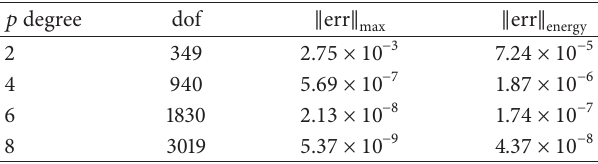
Table 1: Enriched meshfree method errors, measured in max and energy norm.